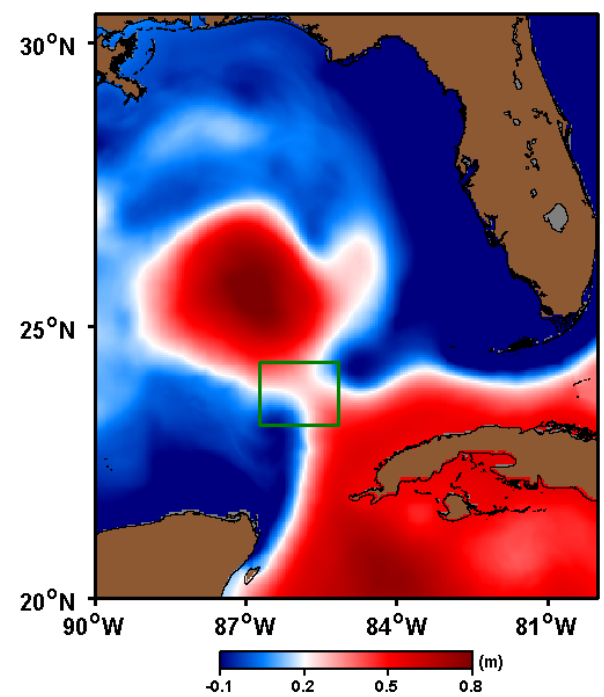
Fig. 1. Sea surface height anomaly (SSHa) of the Loop Current in the Gulf of Mexico during a ring formation event on 10 June 2010. The saddle region in the small box is the focus of this